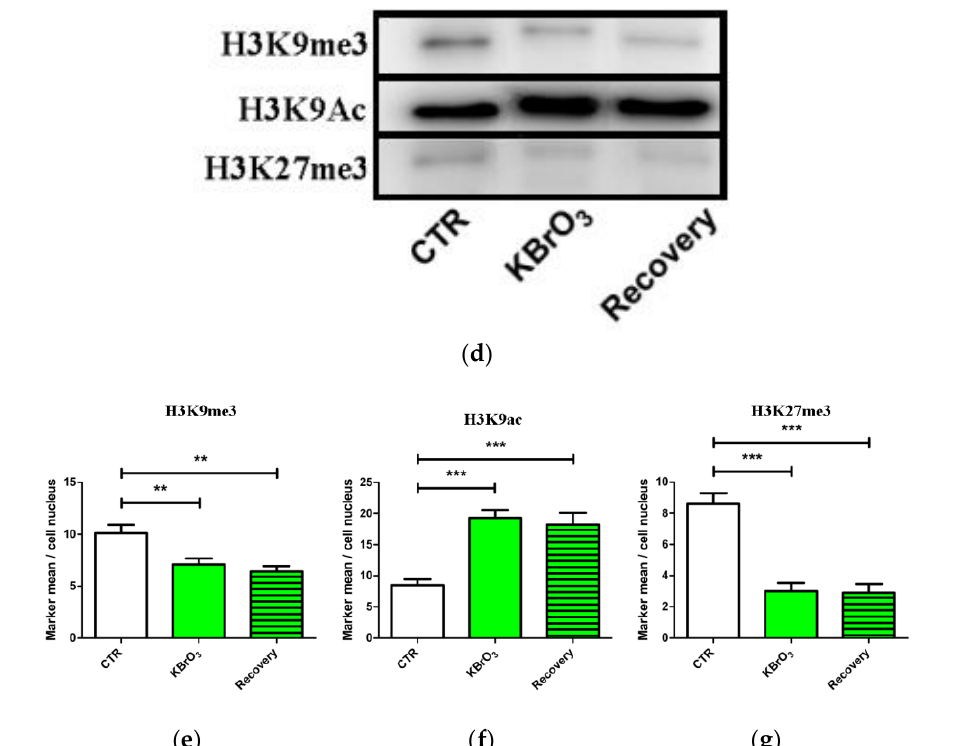
Figure 3. ( a ) H3K9me3 labelling (arrowheads). Note its localization in the heterochromatin. Bars: 1 μm (control); 500 nm (KBrO 3 and recovery). ( b ) H3K9Ac labelling (arrowheads). It localizes in the euchromatin and in the perichromatin region. Bars: 500 nm (control and recovery); 1 μm (KBrO 3 ). ( c ) H3K27me3 (arrowheads). This histone-PTM is found in the three already highlighted chromatin compartments. Bars: 500 nm. ( d ) Western blot analysis of potassium bromate-treated cells with antibody targeting H3K9me3, H3K9Ac and H3K27me3 ( see Figure S1). ( e – g ) Histograms representing the abundancy of the histone PTMs per nucleus. Asterisks identify colloidal gold counting-revealed significant differences. Mean with SEM are reported (**: p Value < 0.01; ***: p Value < 0.001).